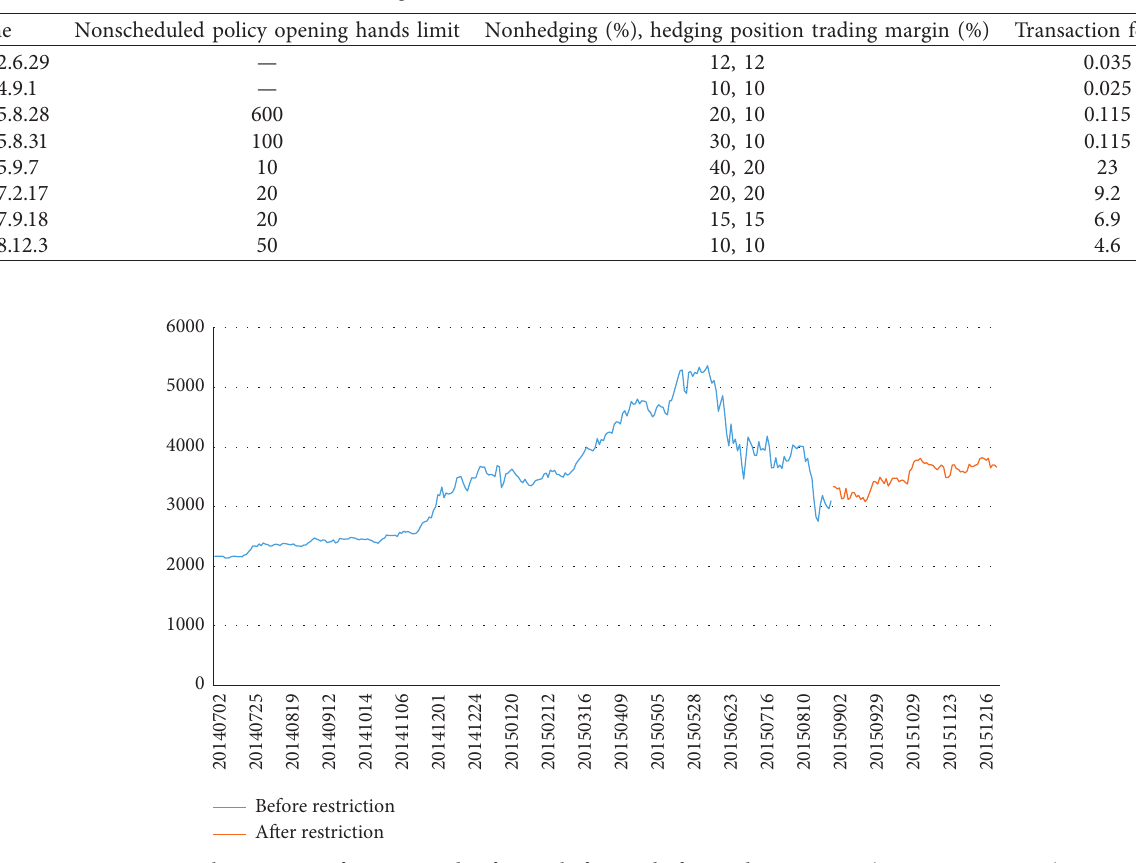
Table 1: Trading rules of CSI 300 index futures (until the end of 2018).